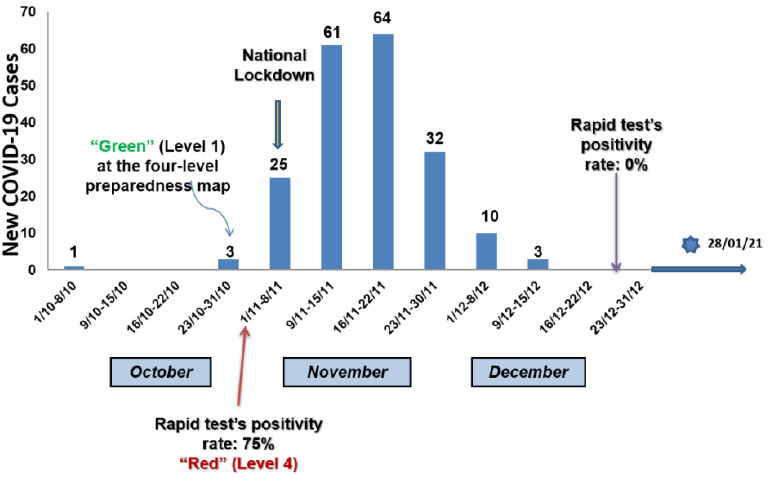
Figure 1. The occurrence of cases, lockdown initiation, and significant time points in the course of the pandemic in Deskati.